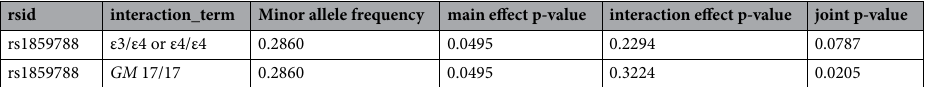
Table 6. Family-based association tests (additive model) in the NIMH cohort for main, interaction and joint effects. Since the FBAT test statistics are derived based on a score test approach, no OR is estimated.